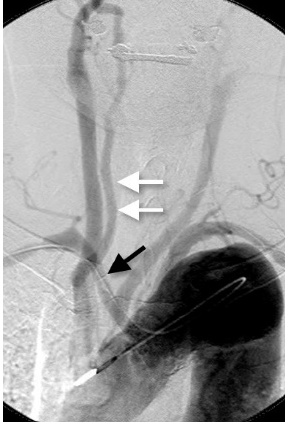
Figure 5. Right VA originating from the common carotid artery with RSCA. Anteroposterior view on aortography shows the RVA arising from the right common carotid artery (double white arrow). An aberrant RSCA is also detected (black arrow).